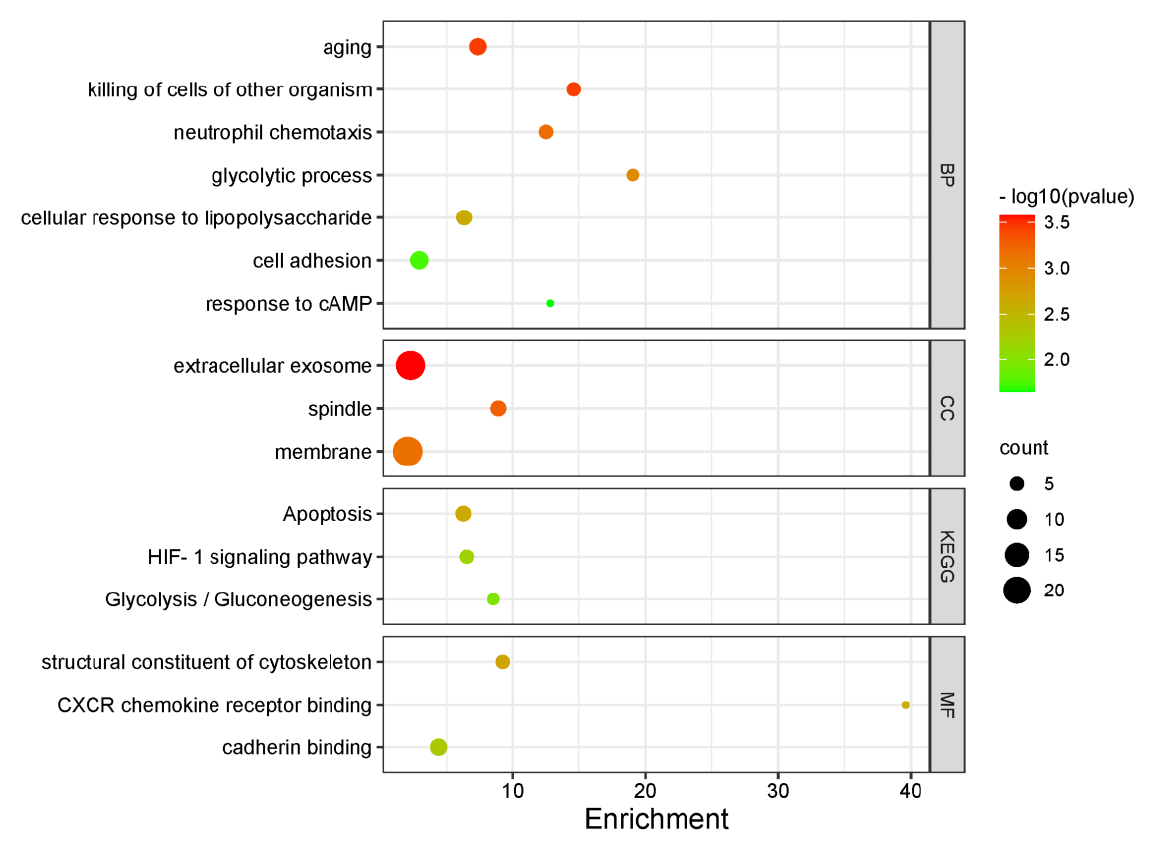
Figure 6. Bubble plot demonstrating significantly enriched GO terms (BP, CC and MF) and KEGG pathways among the top 100 genes with the lowest P values for hazards regression coefficients. Table 4. Enriched GO and KEGG pathway terms in the top 100 genes with the lowest p values with involved genes in each term.